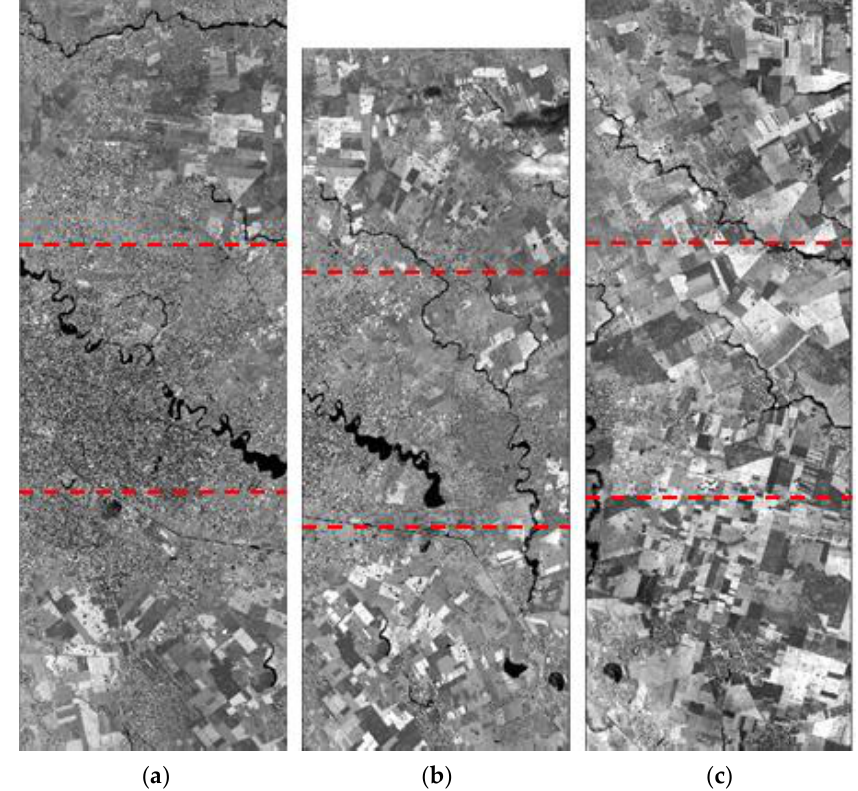
Figure 5. Test image strip of three scenes: ( a ) Strip #1, ( b ) Strip #2, ( c ) Strip #3.